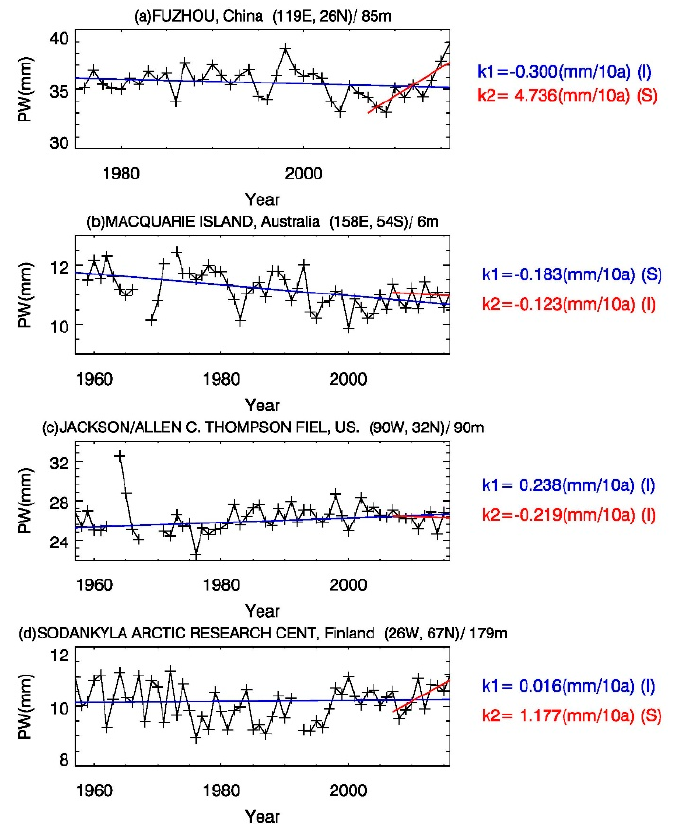
Figure 7. Trends in PW at four stations: ( a ) Fuzhou, China; ( b ) Macquarie Island, Australia; ( c ) Jackson/Allen C. Thompson Fiel, US and ( d ) Sodankyla Arctic Research Cent, Finland. Blue linear lines represent trends during 1957–2016 and red linear lines represent trends for last decade (2007–2016). k1 and k2 represent the slopes of the linear lines. S represents trend significant at the 95% confidence level or greater; I denote the insignificant trend.